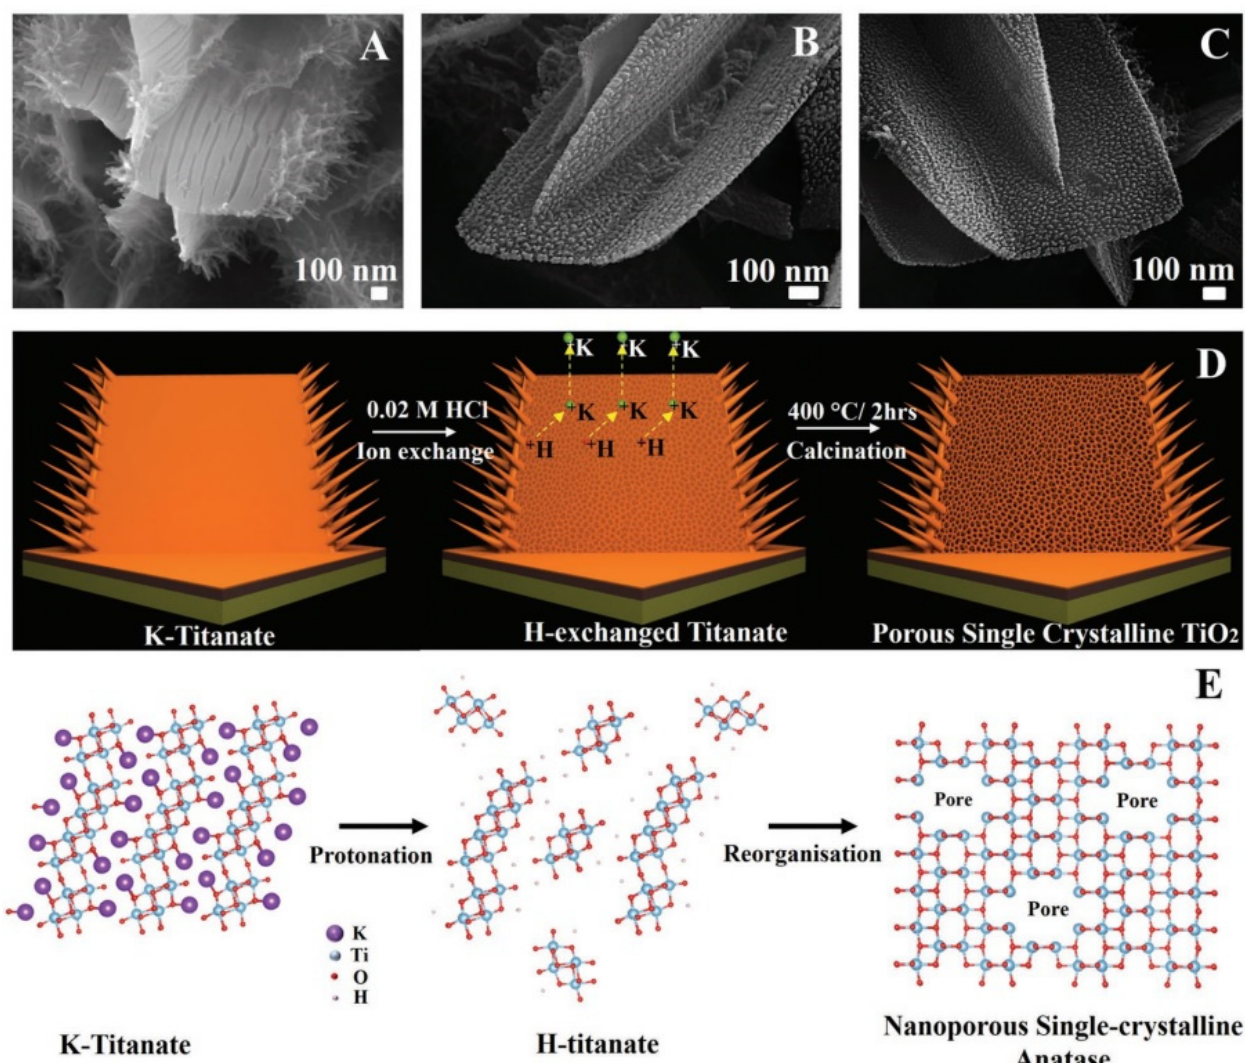
Figure 5. Nanostructure evolution mechanism. SEM images of ( A ) K-titanate, ( B ) H-titanate, and ( C ) porous single-crystalline TiO 2 , respectively. ( D ) Schematic illustration of converting K-titanate to porous single-crystalline TiO 2 via ion exchange followed by calcination. ( E ) Atomic crystal model of crystal structure changes during ion exchange and calcination processes. Reprinted with permission from Butburee et al. [70]. Copyright 2018: